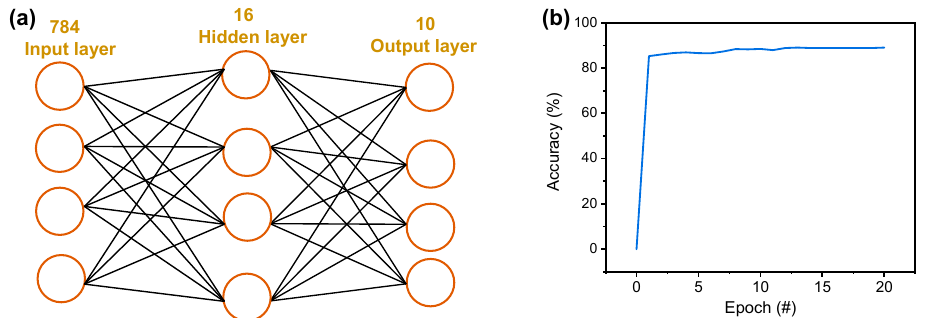
Figure 5. ( a ) Potentiation and ( b ) depression by 50 identical set and reset pulses.